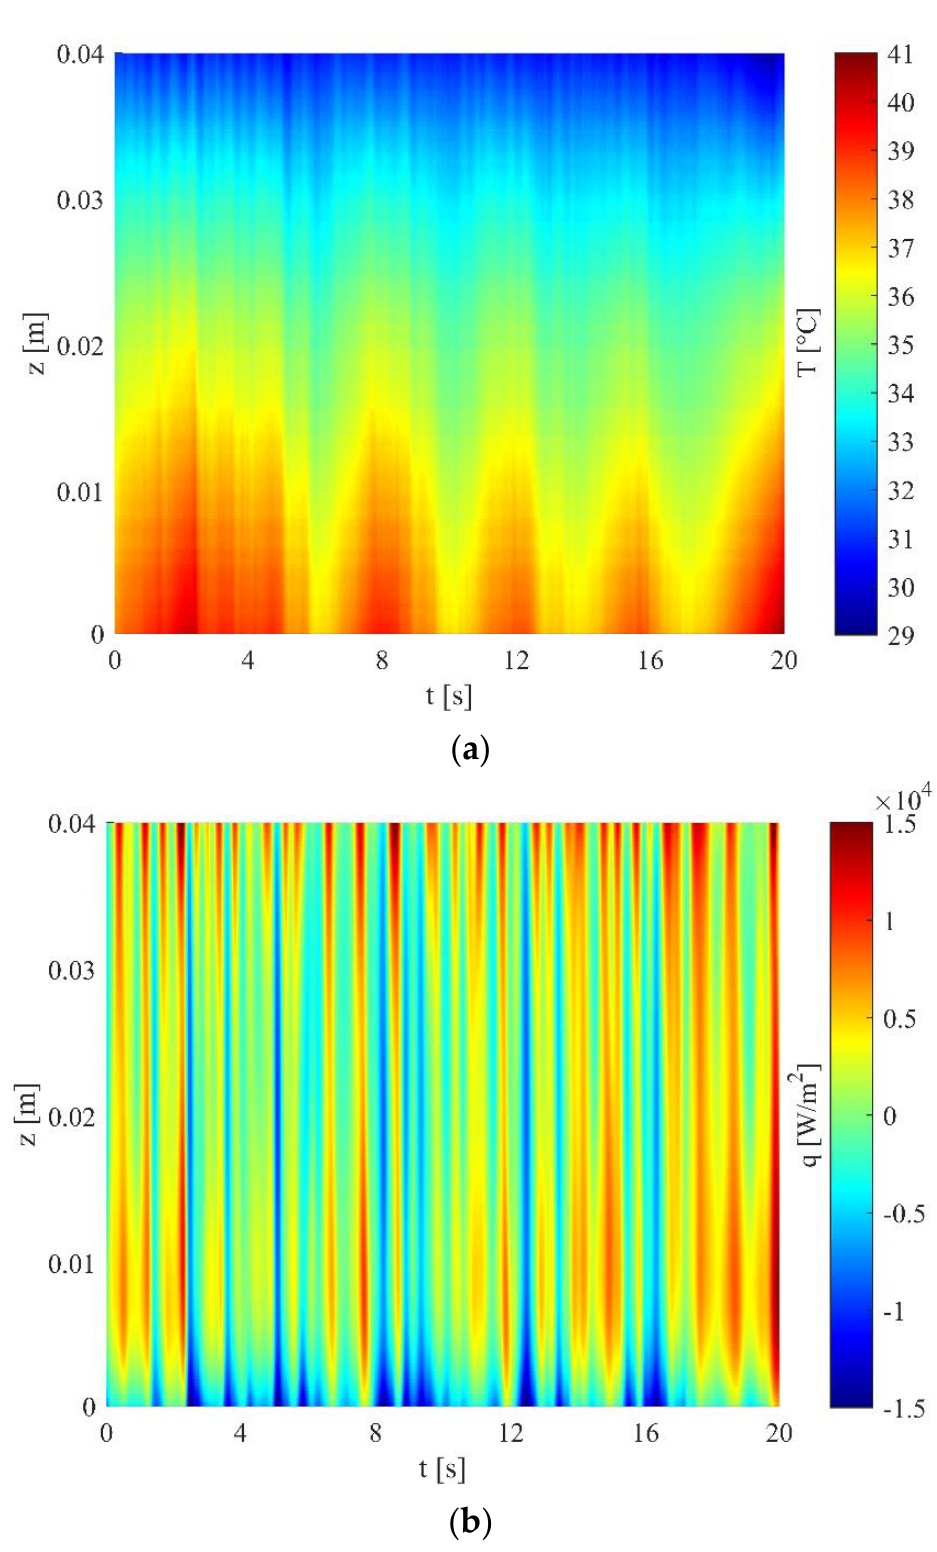
Figure 10. Space–time temperature distribution acquired by means of thermography ( a ) and resulting Figure 10. Space – time temperature distribution acquired by means of thermography ( a ) and wall-to-fluid heat flux q ( b ); (channel 8, horizontal orientation, Q = 200 resulting wall-to-fluid heat flux q ( b ); (channel 8, horizontal orientation, Q = 200 W).